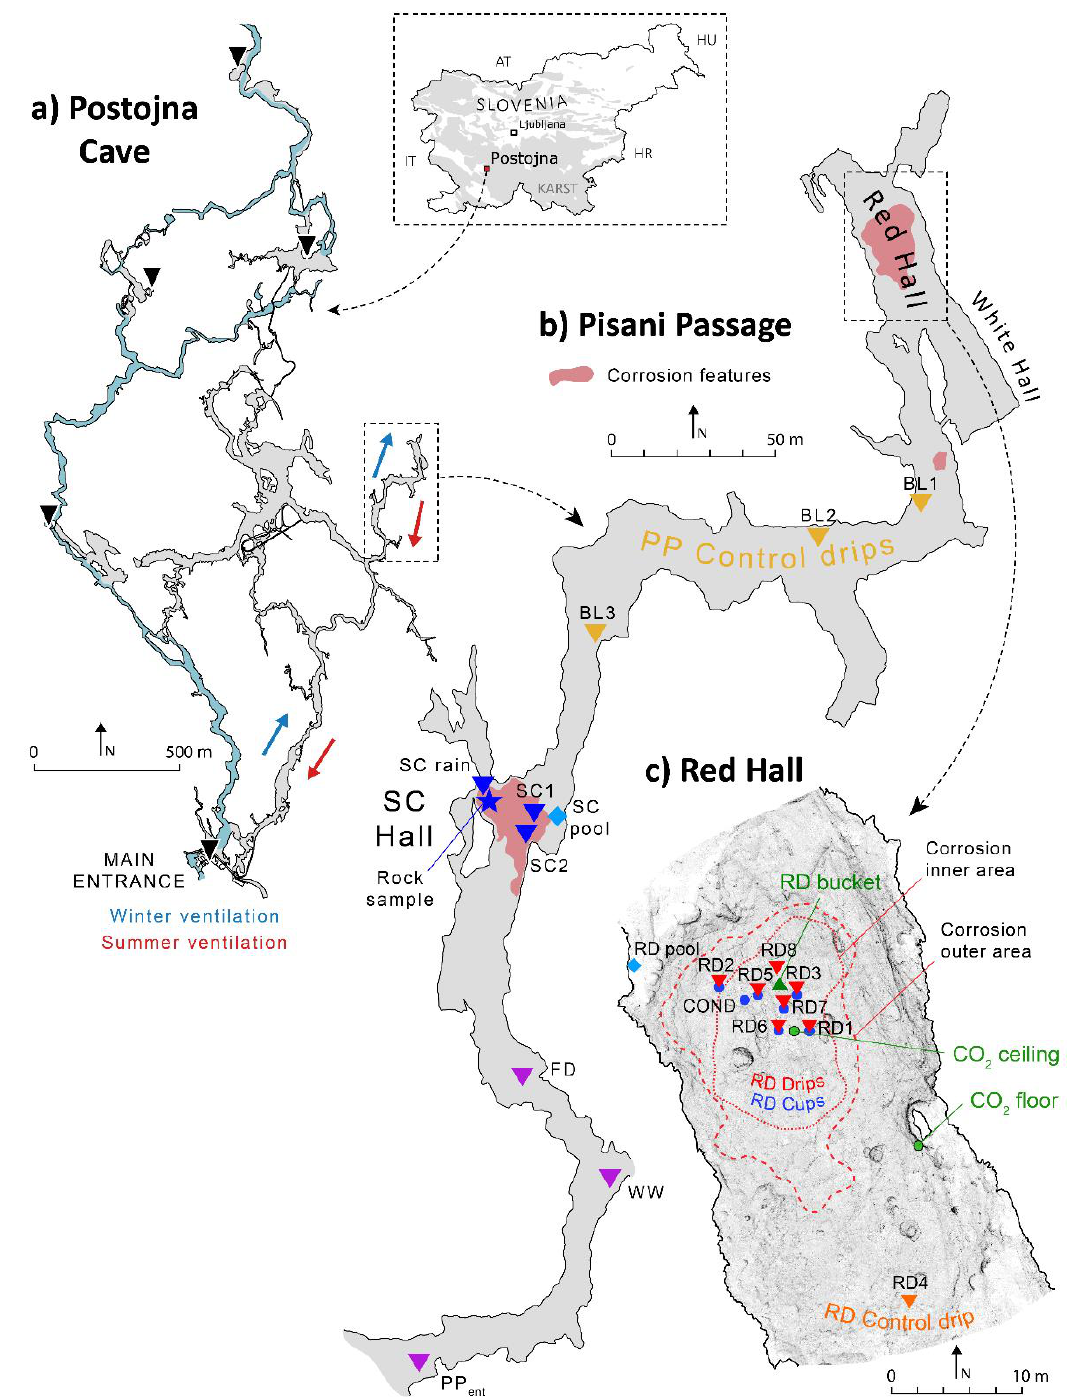
Figure 2. Location of the study site. ( a ) Map of Slovenia showing the location of the cave and plan of Postojna Cave. The typical ventilation pattern is indicated by red and blue arrows showing summer and winter ventilation, respectively. ( b ) Plan of Pisani Passage showing the locations of the numerous corrosion features and sampling sites. ( c ) Plan of the Red Hall showing the largest number of corrosion cups in Pisani Passage. The extent of the corrosion features is indicated by dashed red lines, which are explained in the text. The sampled drip sites are marked with inverted triangles (drips), circles (cups), diamonds (pools) and triangles (bucket). RD drips are coloured red, RD cups and SC drips with dark blue, RD control drip with orange, RD bucket with green, PP control drips with yellow, and three drips located near the entrance of PP with violet. Continuous p CO 2 monitoring sites are indicated by green circles. Map source: Cave cadastre of the Karst Research Institute ZRC SAZU.